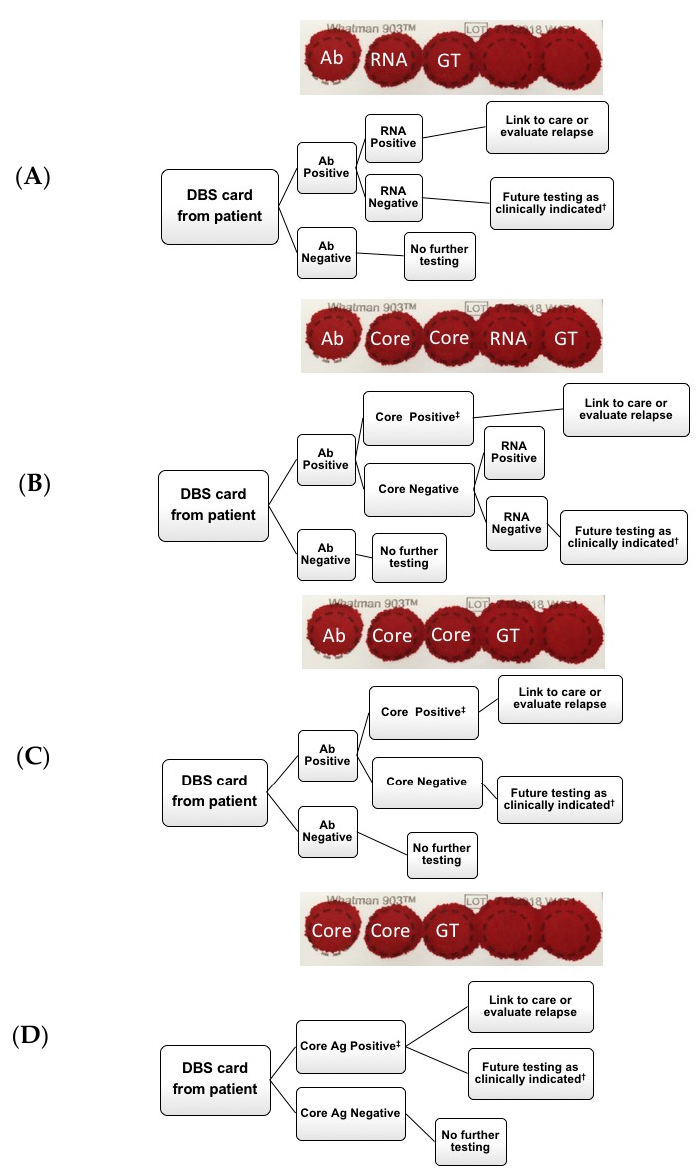
Figure 4. Potential diagnostic algorithms for hepatitis C virus (HCV) testing. ( A ) HCV antibody testing from DBS with subsequent RNA testing, ( B ) HCV antibody testing from dried blood spots (DBS) with subsequent core-Ag testing. If core-antigen (Ag) negative, subsequent RNA testing, ( C ) HCV antibody testing from DBS with subsequent core-Ag testing, ( D ) HCV core-Ag testing from DBS card. † Retest as clinically indicated if suspected seroconversion or ongoing exposure. ‡ Testing ends as a result of positive HCV core antigen. Ab = antibody, Core = core antigen, GT = genotype.